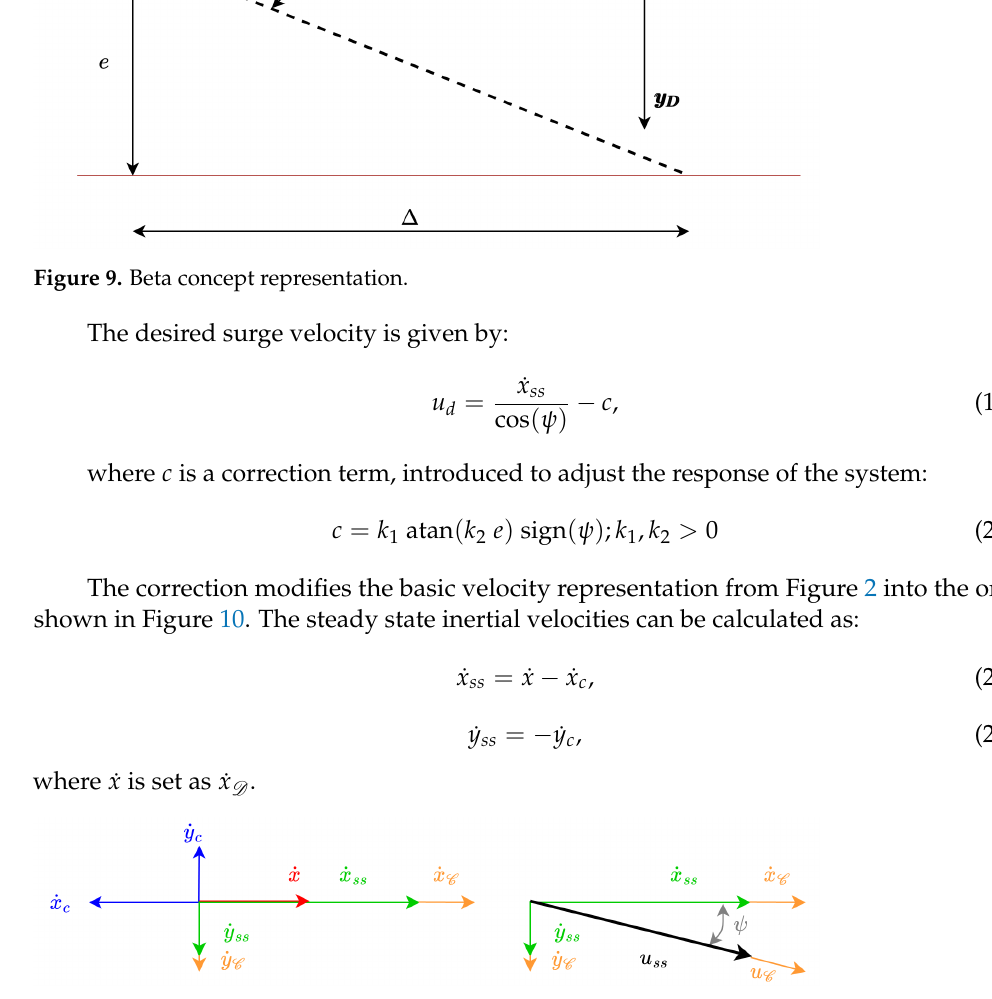
Figure 10. Geometrical representation of corrected velocities. Here, ˙ x ss , and ˙ y ss are through water velocities of the AUV in the steady state in the { D } frame (i.e., when e is zero); u ss the through water velocity of the AUV in the steady state in the { D } frame; and ˙ x C , ˙ y C , and u C the velocities due to c